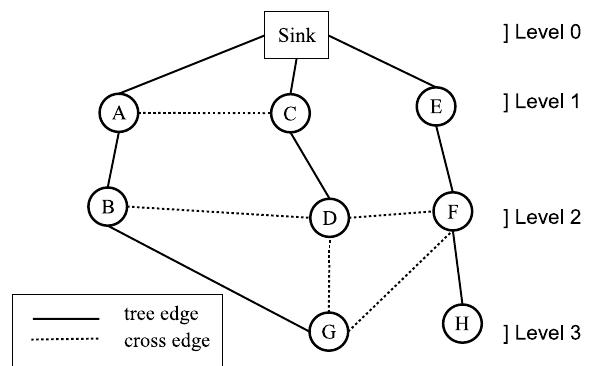
Figure 1. Breadth-first search (BFS)